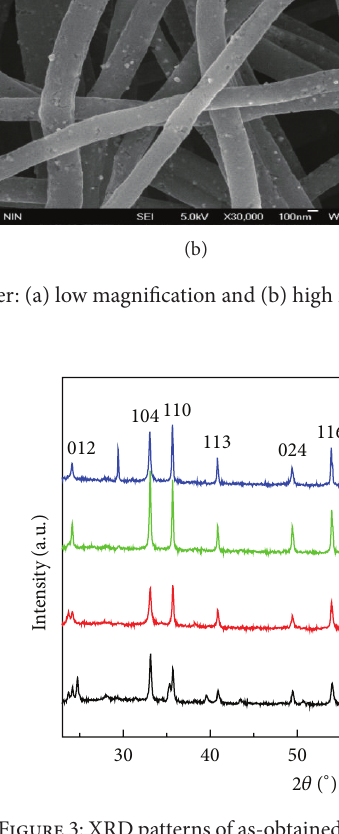
Figure 2: XRD patterns of the as-obtained carbonized PAN fiber.